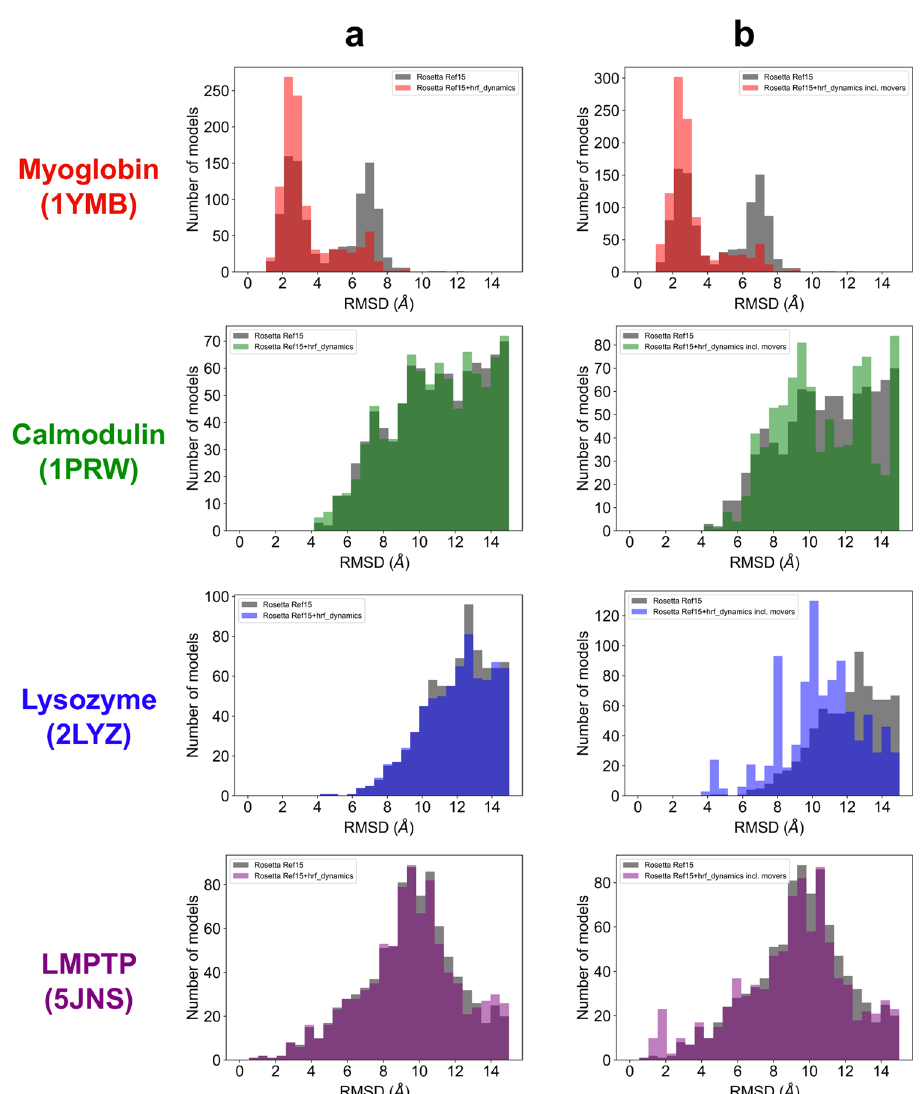
Fig. 4 RMSD histograms for each benchmark protein showing the top 1,000 scoring models. RMSD values range from 0.0 to 15.0 Å with bin widths of 0.5 Å. Myoglobin is red, calmodulin green, lysozyme blue, and LMPTP purple. Color transparency was adjusted to 0.5 for effective visualization of the compared datasets. a The Rosetta Ref15 distribution (gray) is compared to scoring with Rosetta Ref 15 + hrf_dynamics (color). b The distribution from scoring with Rosetta Ref15 (gray) is compared to top models when mover models are included in the distribution and scored with Rosetta Ref15 + hrf_dynamics